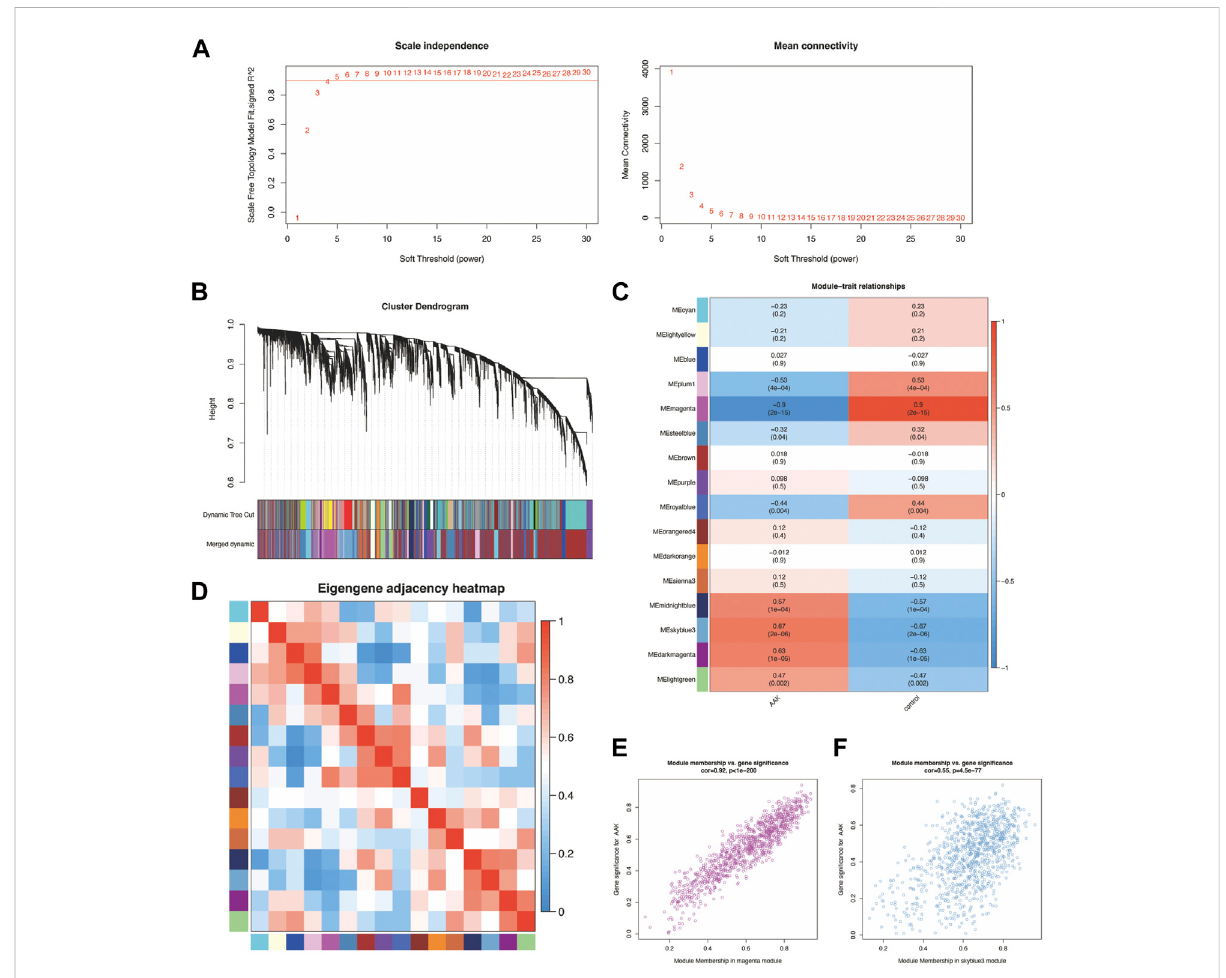
FIGURE 3 Constructionof weighted co-expression network and module analysis. (A) With 0.90 beingdecided as scale independence, thepower value of 4wasselectedas thesoftthresholdoftheadjacency matrix; (B) Thebranchesofthecluster dendro-gramcorrespondto the16gene modules, each piece of the leaves on the cluster dendrogram corresponding to a different gene module. (C) The magenta module (r = − 0.9, p = 2 × 10 − 15 ) module and the skyblue3 (r = 0.67, p = 2 × 10 − 6 ) module were the most strongly correlated with AAK. (D) Heat map of the eigengene adjacency. The colorbarsontheleftandbelowindicatethemodulesforeachroworcolumn; (E) Correlationbetweenmodulemembershipofmagentamoduleand gene signi fi cance with AAK (cor = 0.92, p = 10 − 200 ). (F) Correlation between module membership of skyblue3 module and gene signi fi cance was shown in cor = 0.55 and p = − 4.5 × 10 − 77